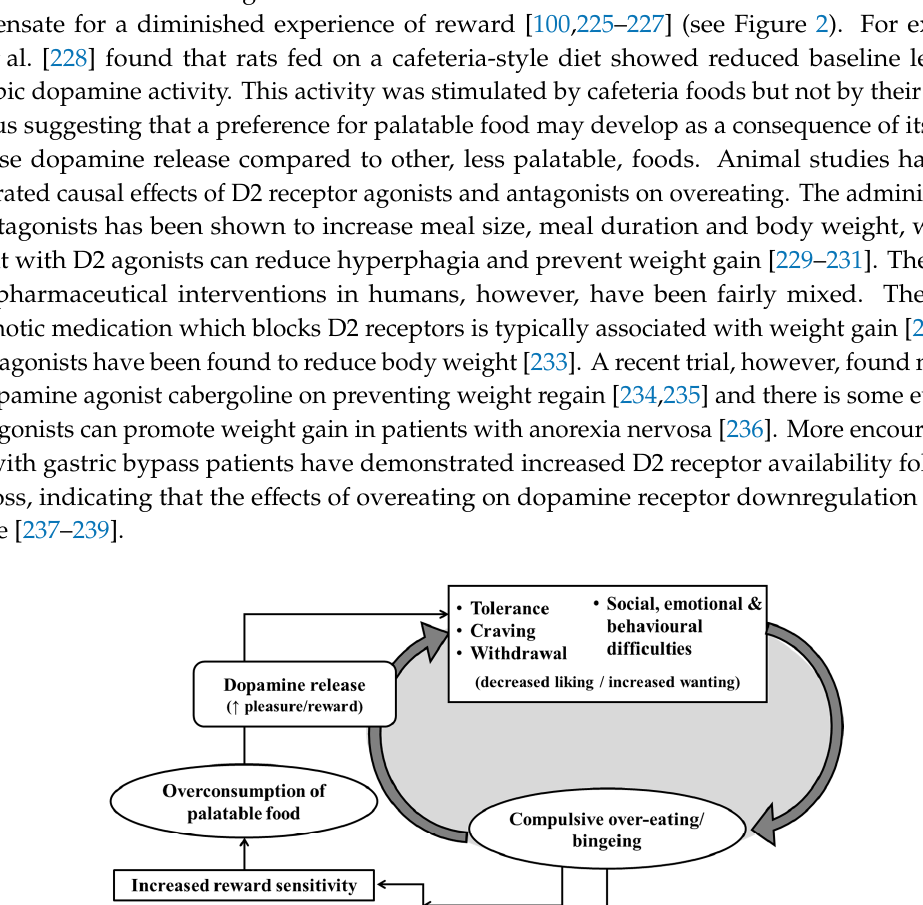
creating a cycle of food